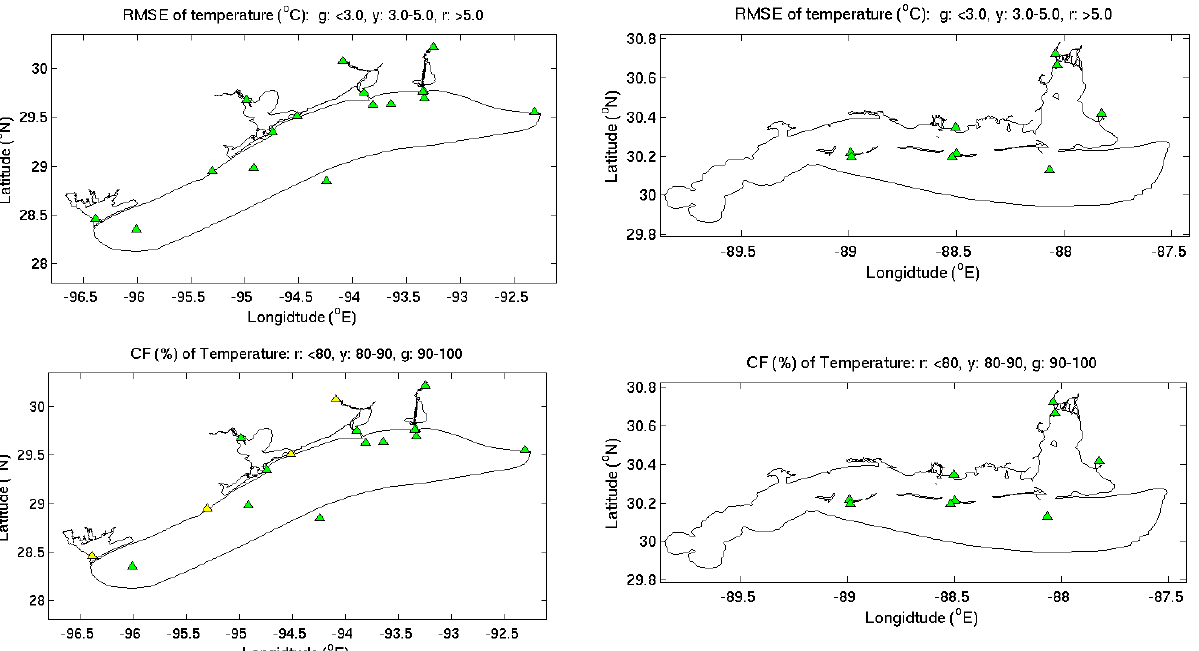
Figure 13. Hindcast temperature RMSE and CF skill assessment summary map for NWGOFS (left column) and NEGOFS (right